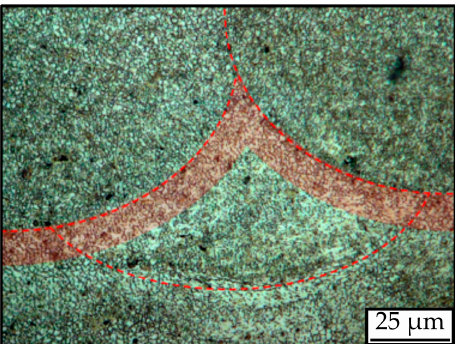
Figure 11. Heat affected zone of superimposition region of two neighboring melt pools in a sample of batch B Mg . Etchant: Nital 2%.